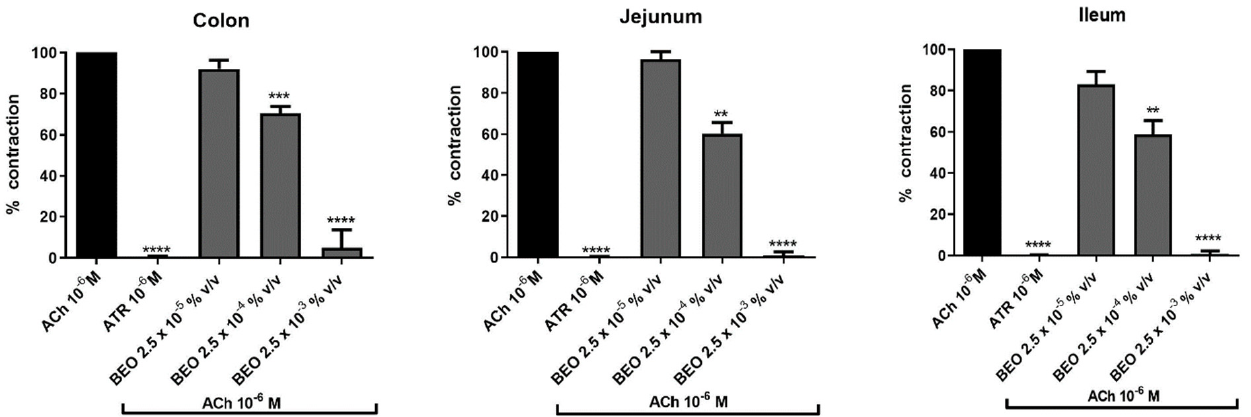
Figure 1. Effect of BEO on ACh-evoked contraction in colon, jejunum and ileum of rat. Each column represents the mean of 3–6 rats. Vertical lines show standard error of mean. ** p < 0.01, *** p < 0.001 and **** p < 0.0001 show the statistical significance between the concentrations of BEO tested on ACh-contraction versus ACh-contraction control ( t -tests). ACh = acetylcholine, ATR = atropine BEO = bergamot essential oil.